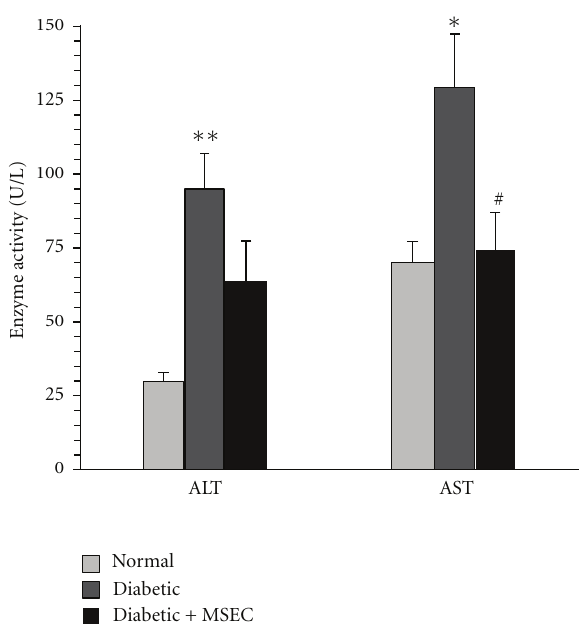
Figure 4: E ff ect of MSEC on serum alanine aminotransferase (ALT) and aspartate aminotransferase (AST) activities in diabetic rats. The animals in group of diabetic + MSEC received diet containing 4% (w/w) of MSEC for 1 month. ∗ P < 0 . 05 versus normal and diabetic + MSEC groups. ∗∗ P < 0 . 01 versus normal rats. # P < 0 . 05 versus diabetic group. The data are expressed as mean ± SEM for eight (normal and diabetic + MSEC groups) or six (diabetic groups)